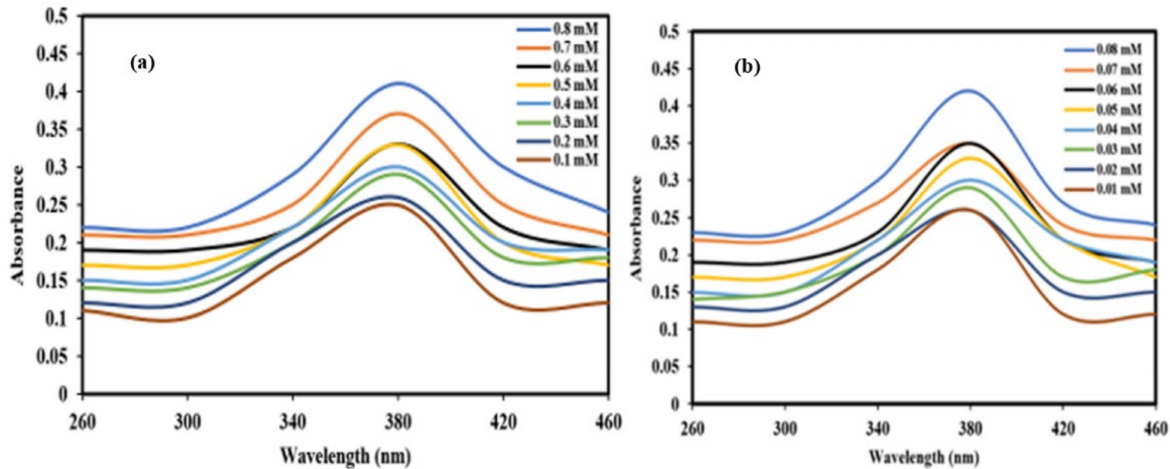
Figure 11. ( a ) The UV-vis absorbance spectra changes in the presence of catechol (0.8 mM, 0.7 mM, 0.6 mM, 0.5 mM, 0.4 mM, 0.3 mM, 0.2 mM, and 0.1 mM).(MgFe 2 O 4 @Mn 3 O 4 (1:2) nanocompos- ite solution of pH 3.0 at 25 ◦ C) ( b ): The UV-vis absorbance spectra changes in the presence of resorcinol (0.01 mM, 0.02 mM, 0.03 mM, 0.04 mM, 0.05 mM, 0.06 mM, 0.07 mM, and 0.08 mM). (MgFe 2 O 4 @Mn 3 O 4 (1:2) nanocomposite solution of pH 3.0 at 25 ◦